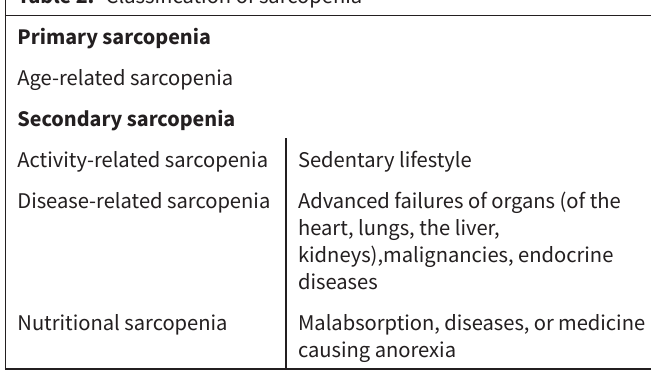
Table 2. Classification of